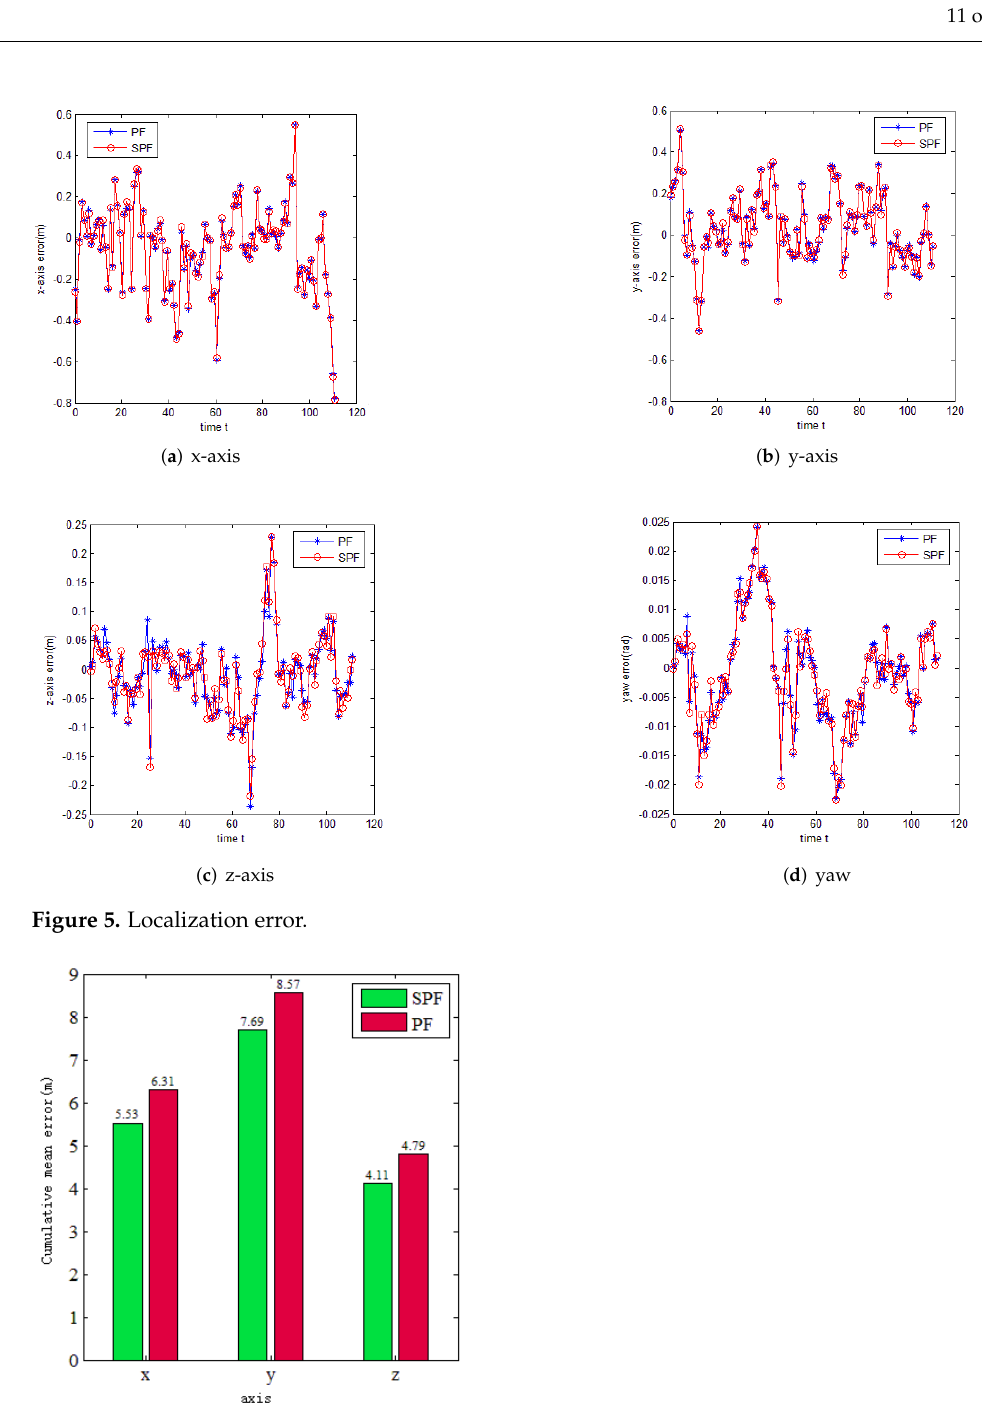
Figure 6. Cumulative mean